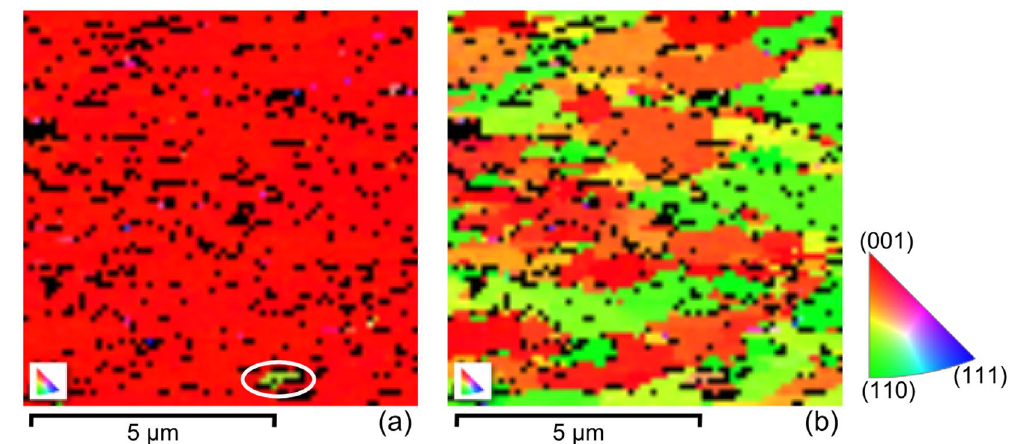
Figure 2. Pole figure maps in the ( a ) out-of-plane and ( b ) in-plane of the PZT film generated using electron backscatter diffraction